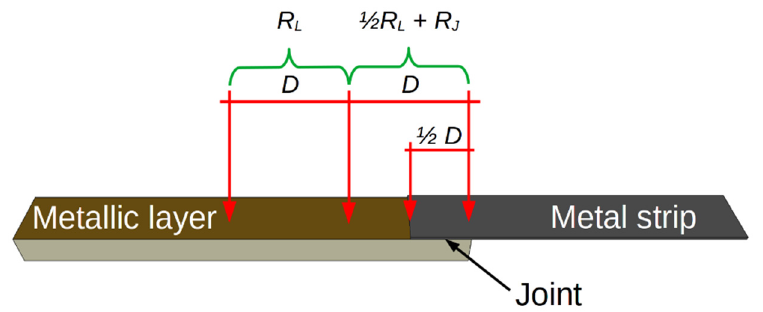
Figure 3. Method of measuring the resistance of joined elements at cryogenic temperatures.